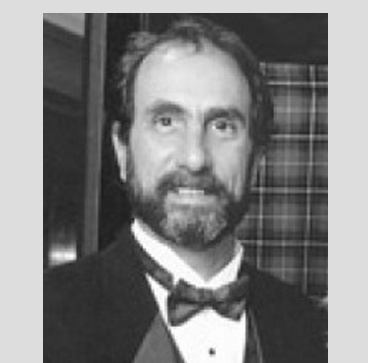
table hockey, promoting the game